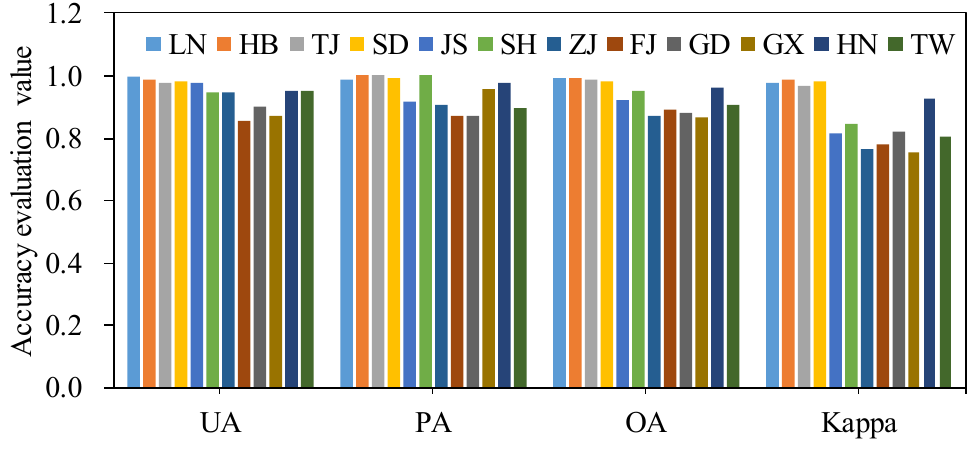
Figure A1. Distribution of three types of land cover data products in the study area.